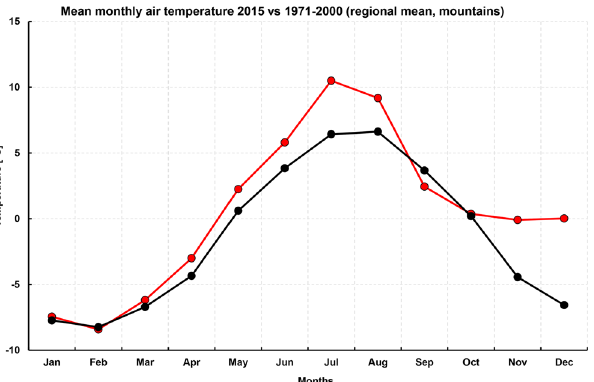
Figure 2. Annual cycle of monthly temperature averaged over the four high elevation sites of Fig. 1 in 2015 (red curve) and for the 1971–2000 mean (black